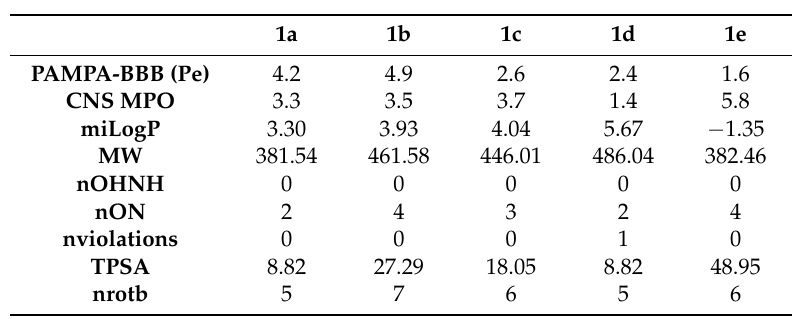
Table 3. Molecular properties of compounds 1